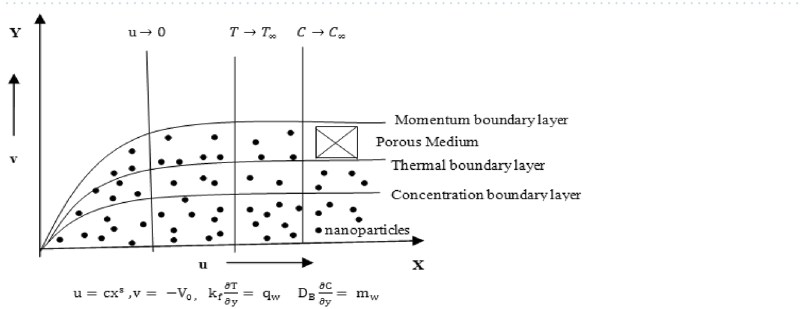
Table 1. Water and ferronanoparticlesthermo physical properties.